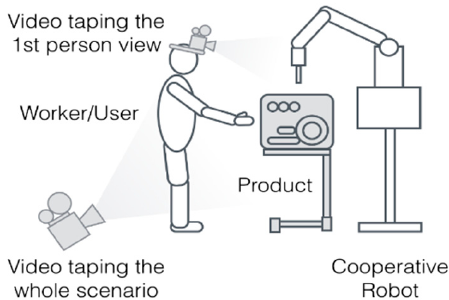
Figure 3. Schematic representation of human–robot interaction.